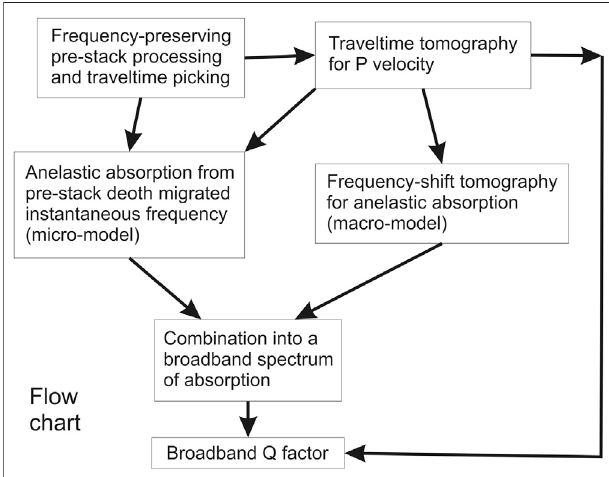
FIGURE 11 | Flow chart for the broadband estimation of anelastic absorption and Q factor.